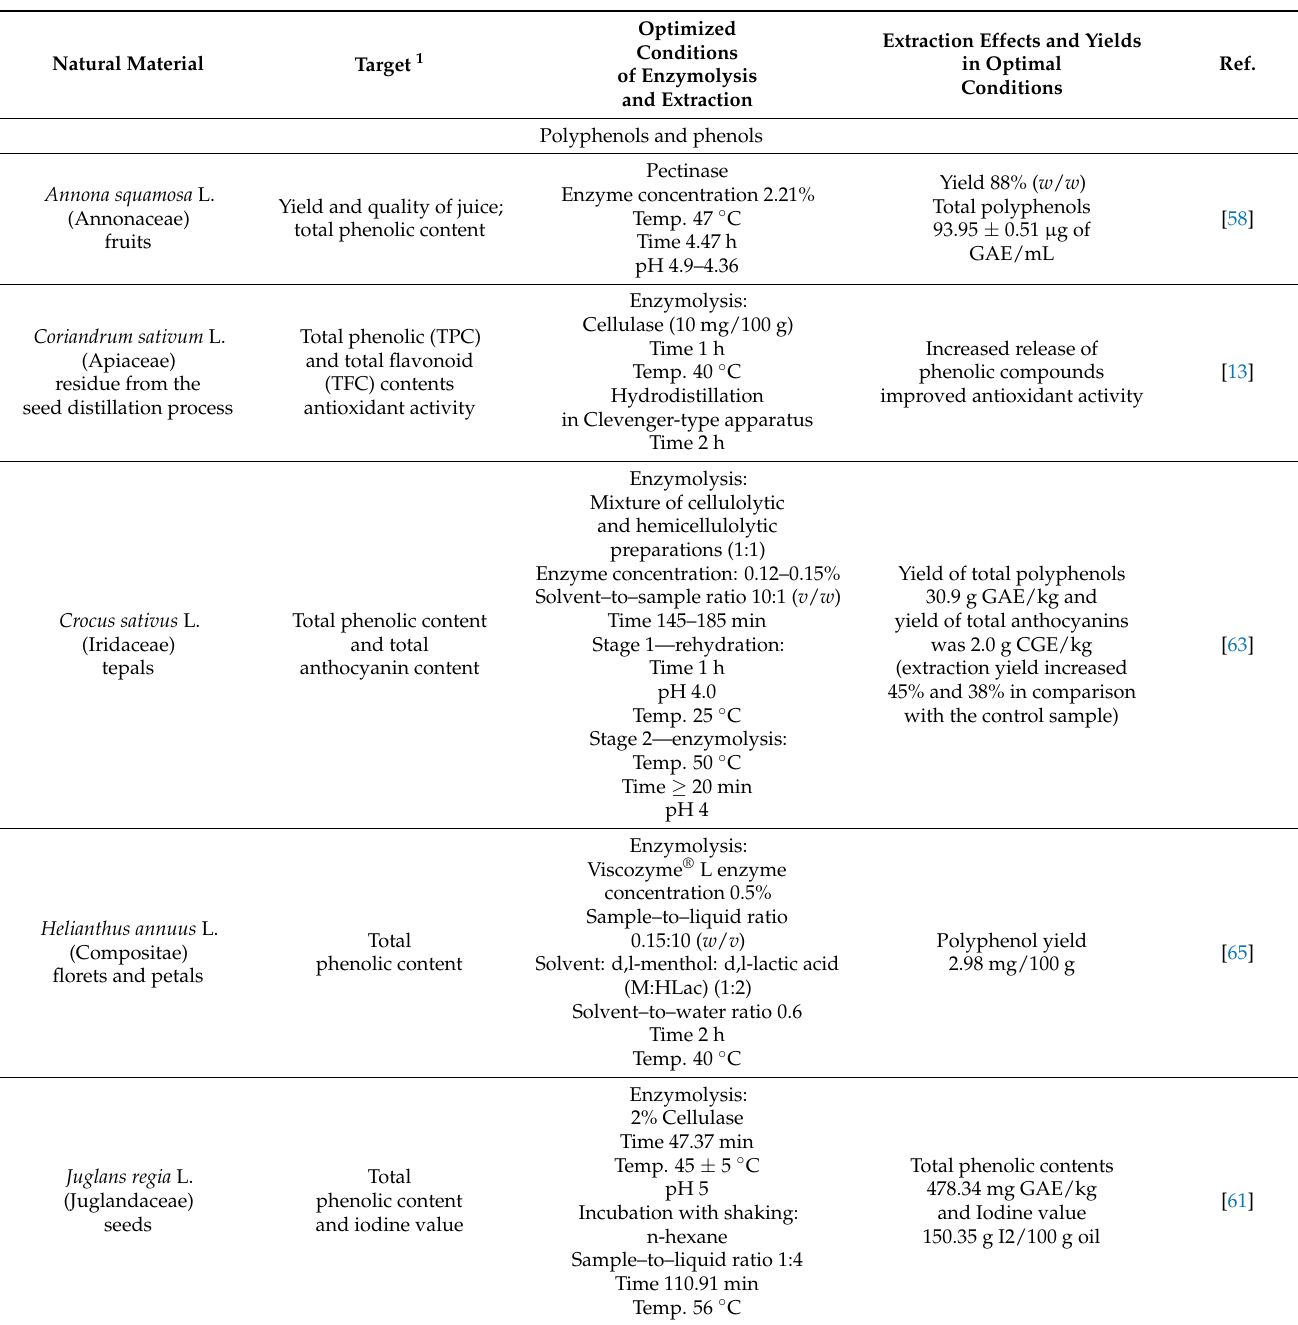
Table 1. Examples of studies on enzyme-assisted extraction of metabolites from natural materials (plants, mushrooms, and